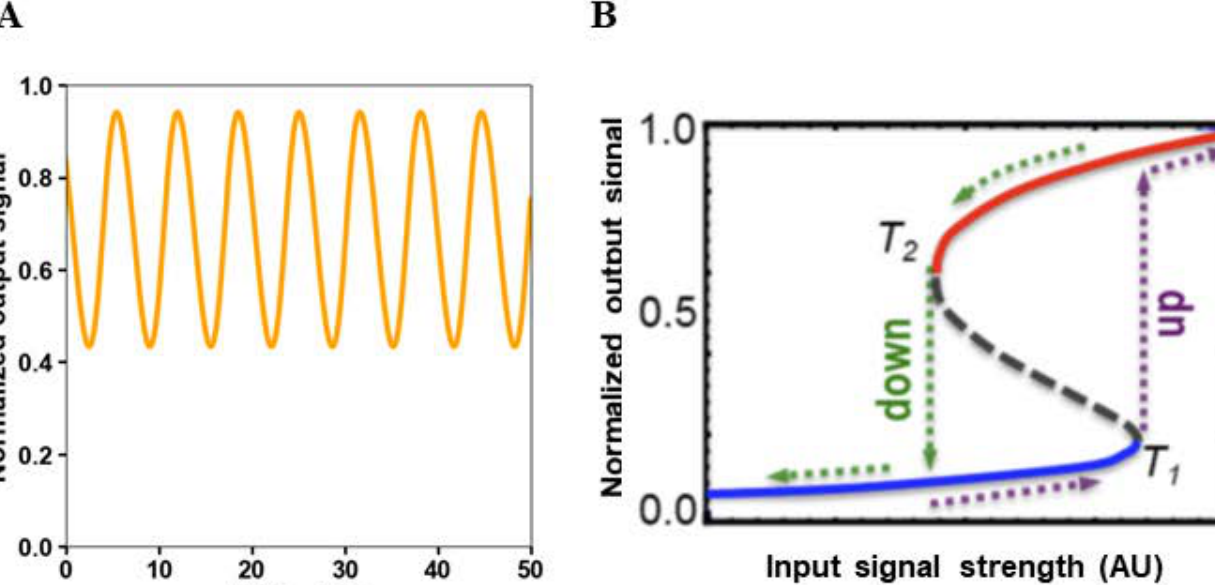
Figure 3. Oscillations and hysteresis brought about by negative and positive feedback loops. ( A ) Typical sinusoidal shapes of oscillations caused by strong negative feedback. ( B ) Hysteresis, a hallmark of bistability, is often triggered by positive feedback. When the input signal increases over the threshold ( T 1 ), the output pathway activity, which initially gradually increased with the input signal, abruptly jumps to a much greater value and then again gradually increases with the further signal increase (the direction of the changes is shown by dashed brown arrows). Following this jump to the higher activity state, the output activity remains high with the decrease in the input signal, and only when this signal reduces to the value ( T 2 ) that is much smaller than T 1 , the output activity returns to the low activity state (dashed green